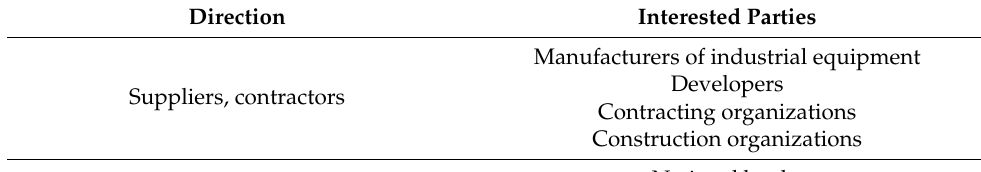
Table 2. Subjects in the digital public–private partnership (PPP) platform [32].